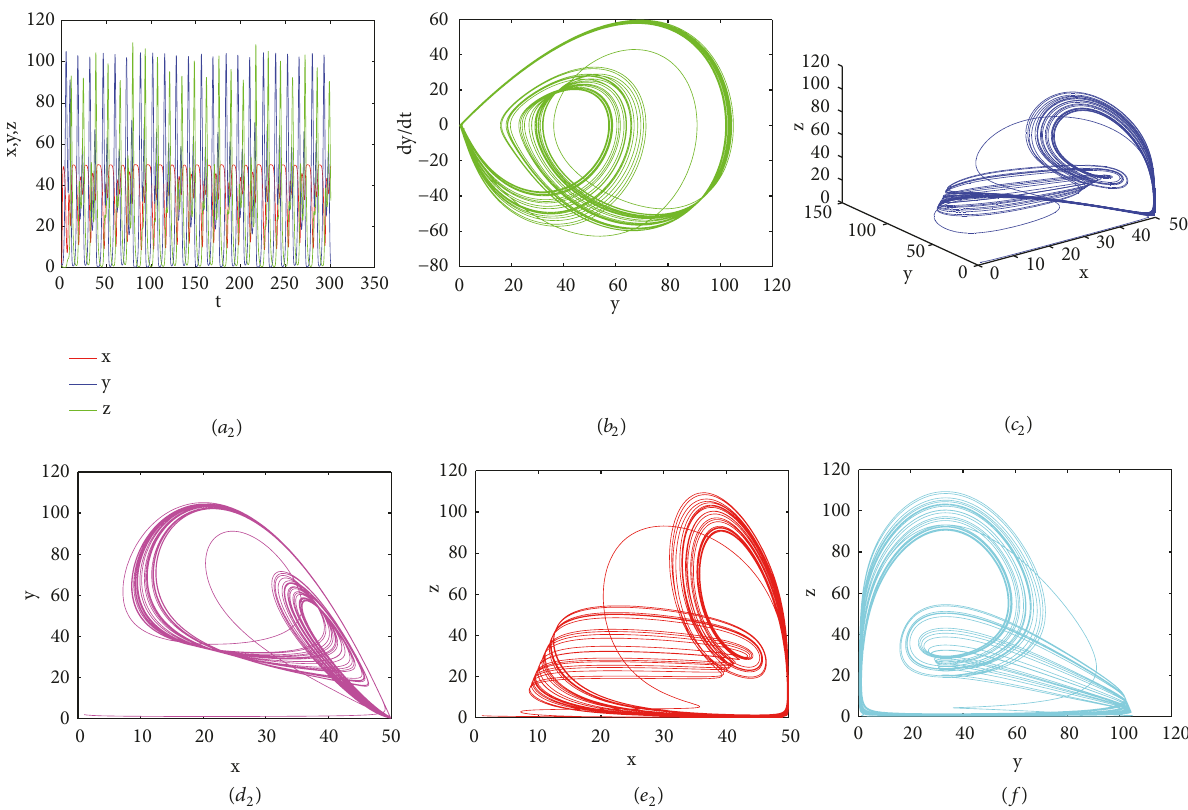
Figure 2: The three-species food chain model for Experiment 1 with 𝑟 = 4.2 : (𝑎 2 ) time series plot; (𝑏 2 ) phase diagram of 𝑦 ; (𝑐 2 ) on the three-dimensional space; (𝑑 2 ) projected on the (𝑥,𝑦) -plane; (𝑒 2 ) projected on the (𝑥,𝑧) -plane; (𝑓) projected on the (𝑦, 𝑧)